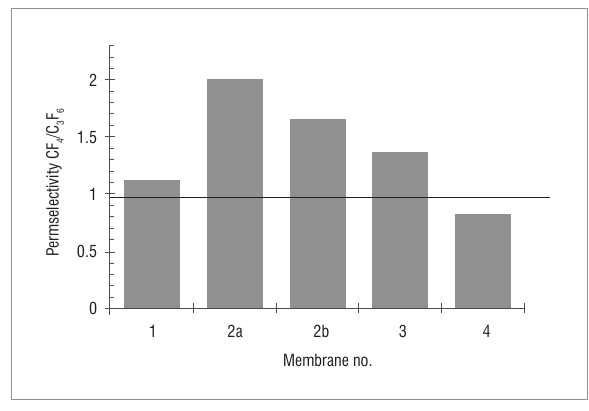
/C F for the (1) ceramic support, (2a) 4 3 6 /C F is indicated by the horizontal line. 4 3 6